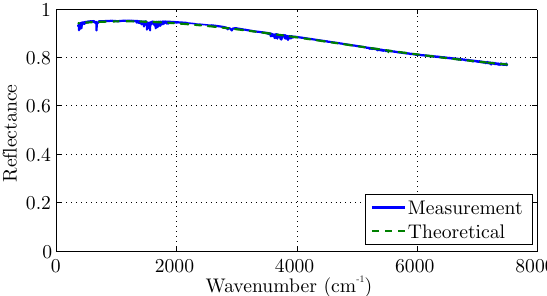
Figure 8. The measured versus the theoretical infrared spectrum of an uncoated region of the metallic